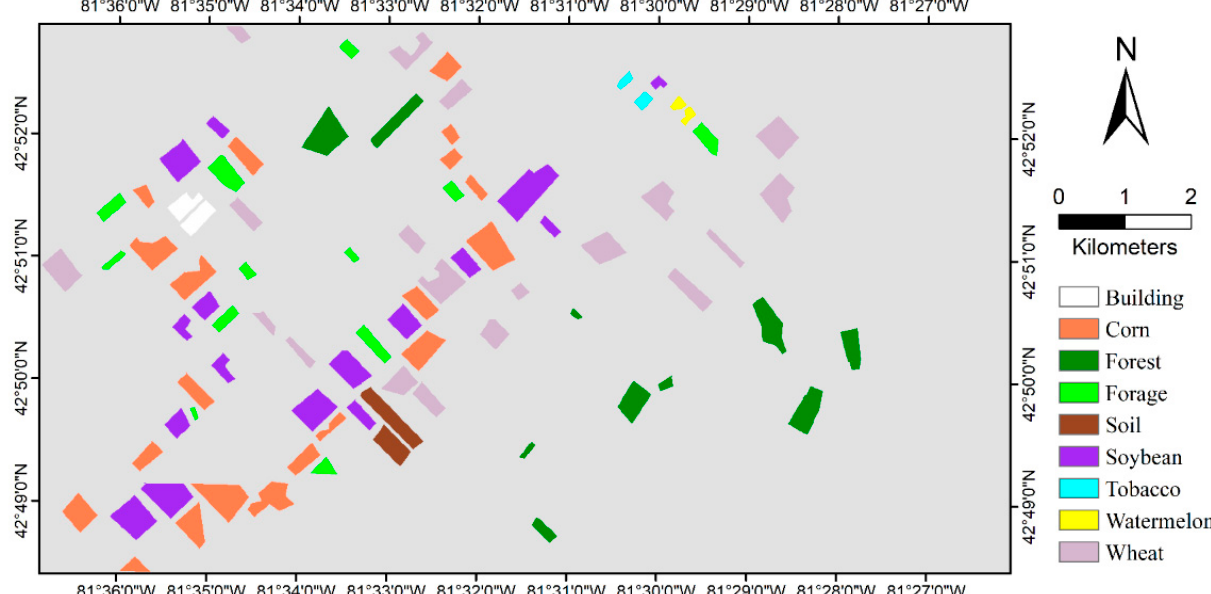
Figure 4. Map of ground truth of the study site from field survey by the Geographic Information Technology and Application (GITA) Lab, UWO in 2015. Table 2. The identified crop fields and the number of pixels for classification training and testing. Land Cover